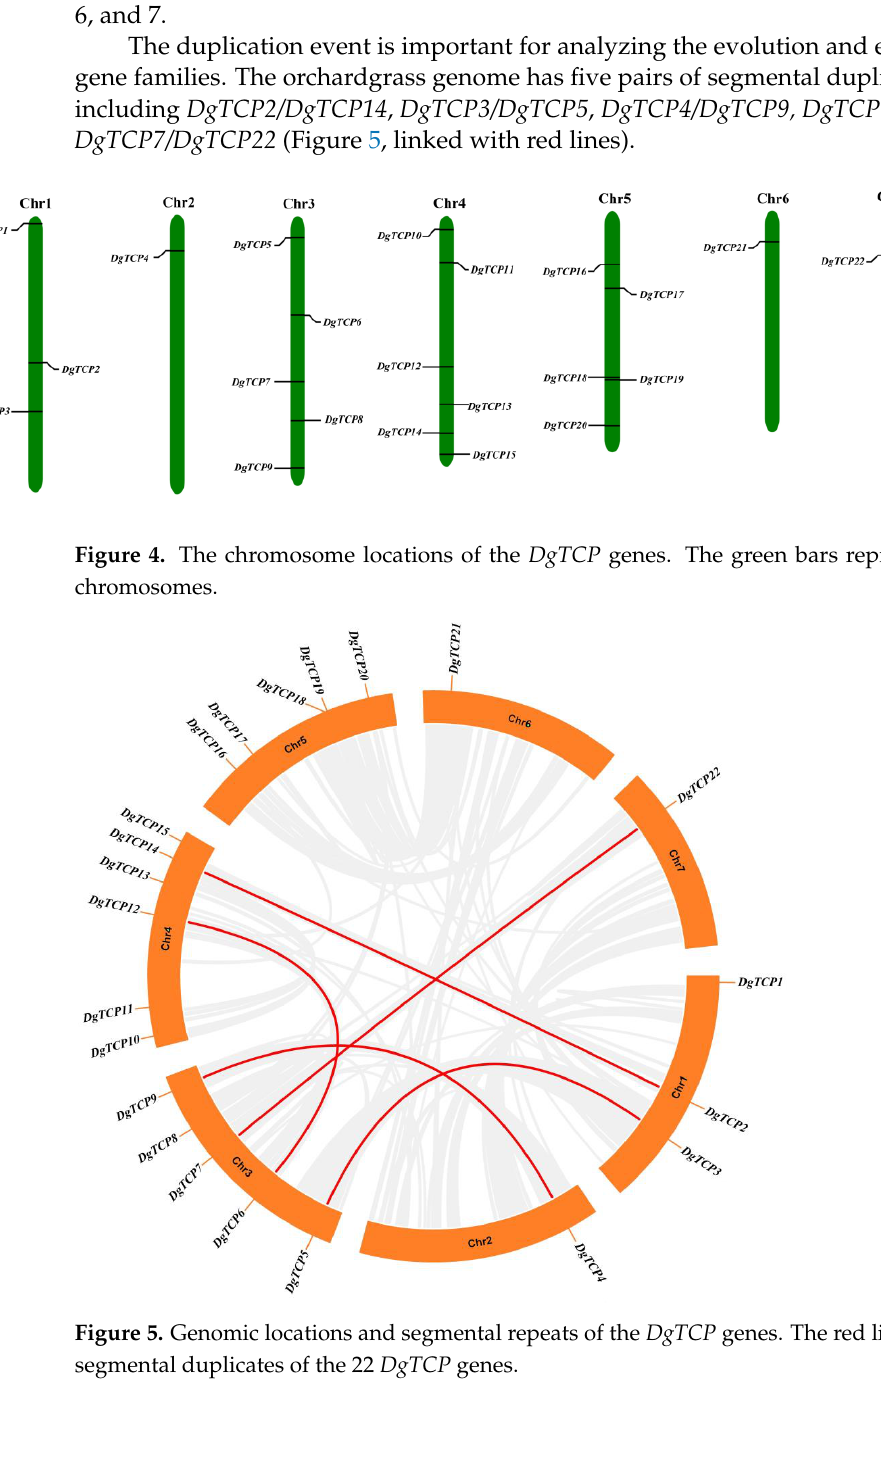
Figure 3. The phylogenetic tree of the orchardgrass TCP gene family, the gene structures, and the motifs. ( a ) The phylogenetic tree of D glomerata TCP proteins ( DgTCP ). ( b ) Exon–intron structures of DgTCP proteins. Blue squares indicate UTR, black lines indicate introns, and green squares indi- cate CDS. ( c ) The colored squares represent the conserved motifs of the DgTCP proteins.